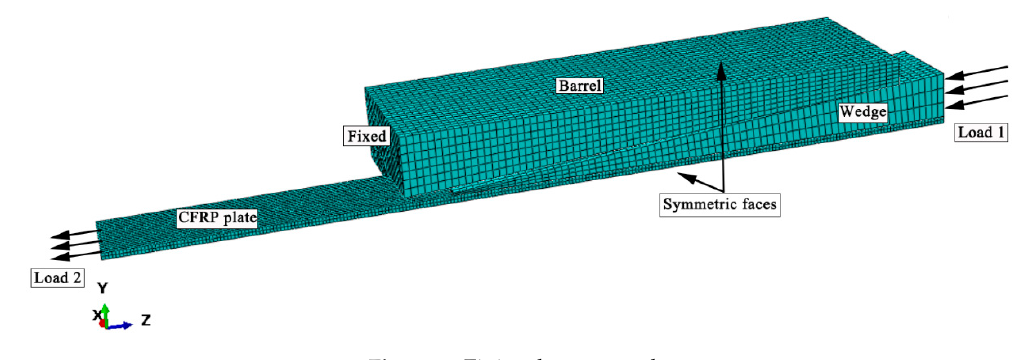
Figure 6. Finite element mesh.